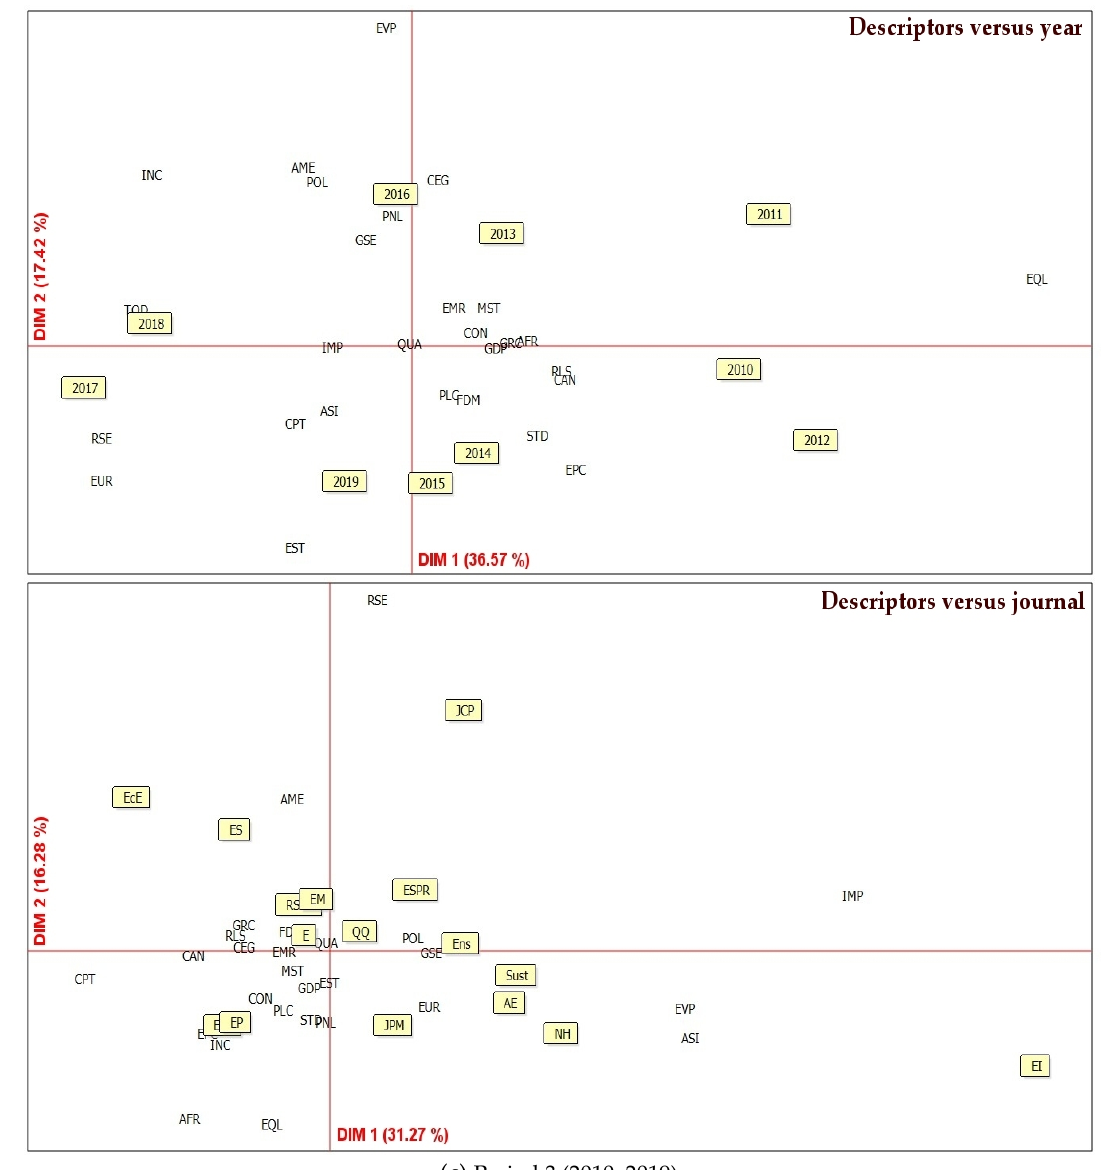
Figure 5. Maps of the field for three periods.